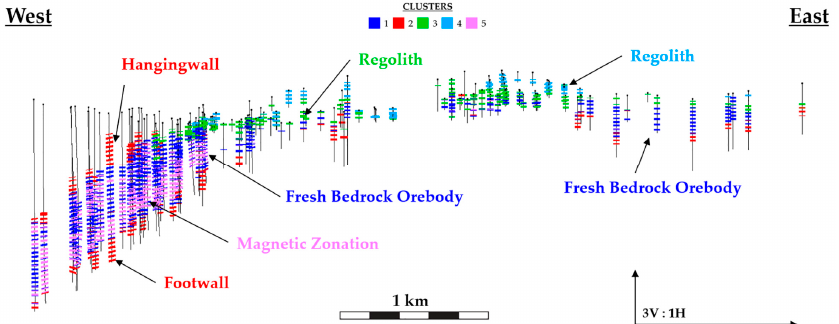
Figure 13. Cross-section looking north at Paracatu (VEX: 3 to 1). Observations represented by PCA cluster membership within their drillhole sample. Section thickness includes north to south extent of mine site. The physical meaning of clusters to the orebody are shown by annotations.